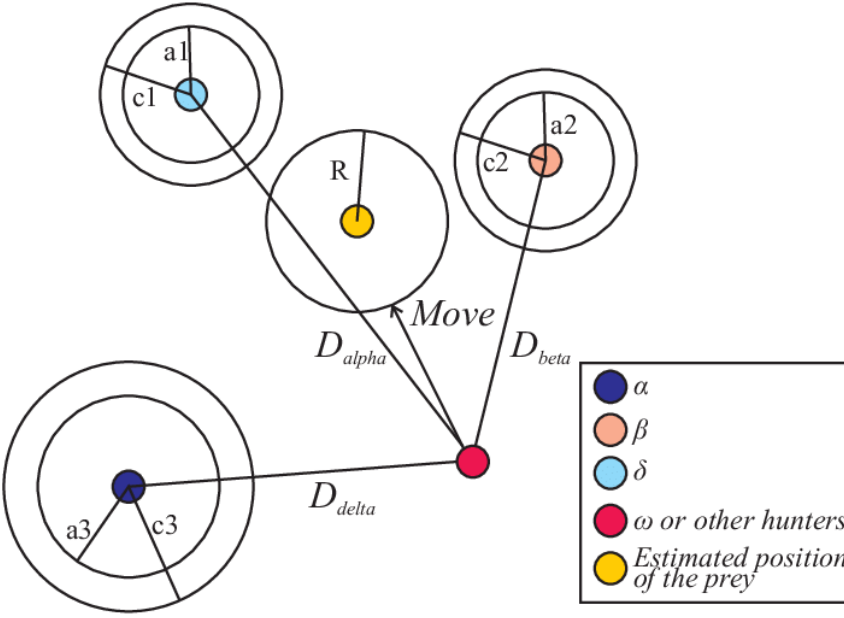
Figure 7. Updated position of a particle in GWO.